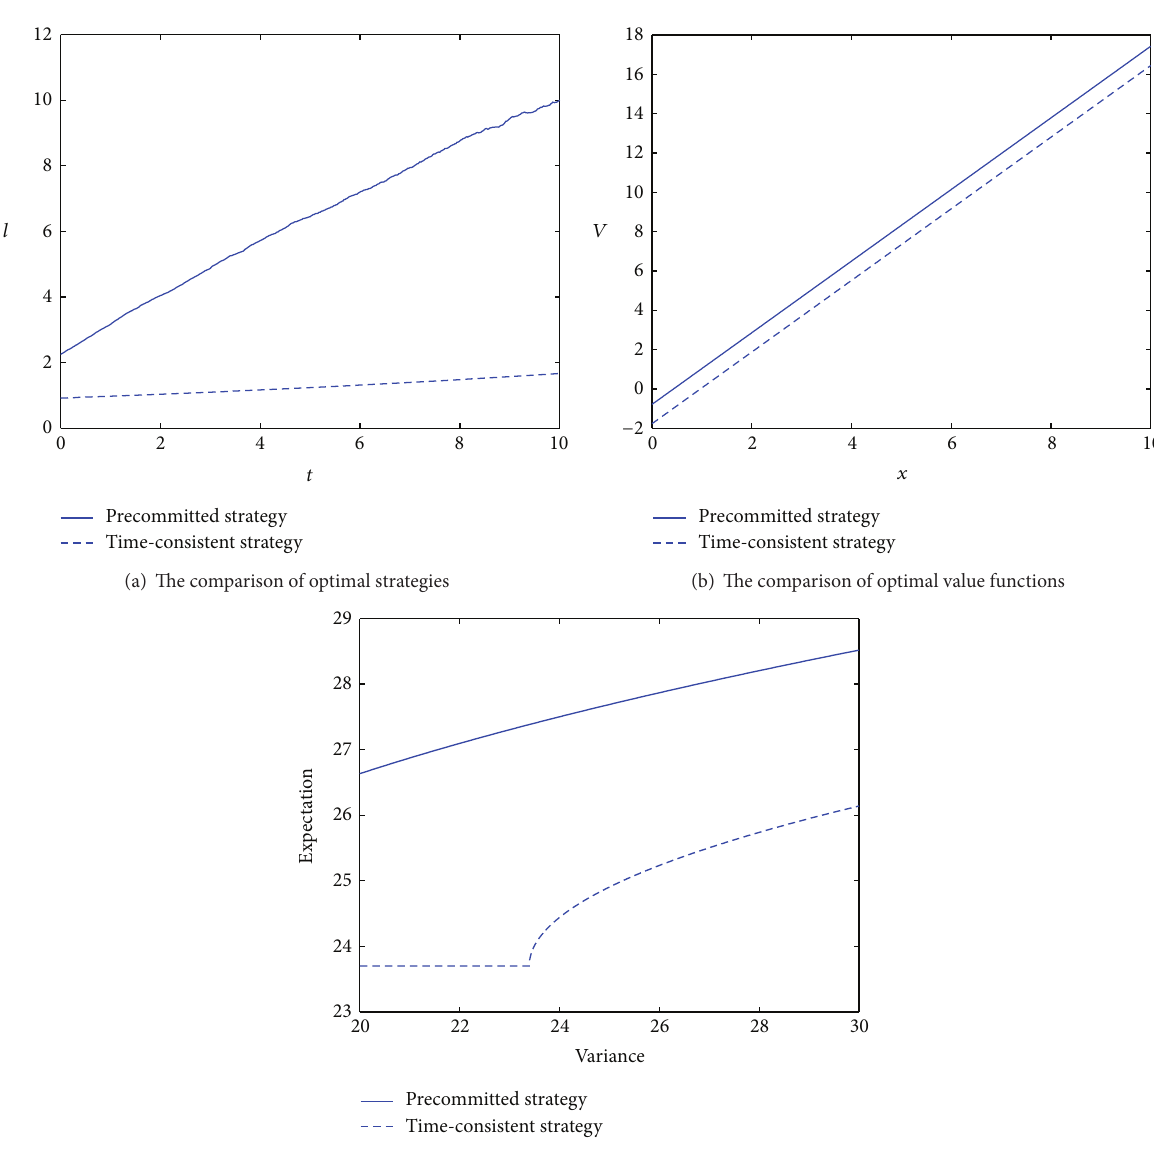
Figure 1: The comparisons between precommitted strategy and time-consistent strategy with parameters 𝑟 0 = 0.06 , 𝑟 1 = 0.15 , 𝑐 = 0.6 , 𝑥 = 10 , = 1 , 𝜎 = 1.1 , 𝜎 = 0.3 , and 𝑇 = 10 𝛾 = 0.6 , 𝜆 = 1 , 𝜇 𝑧 𝑧